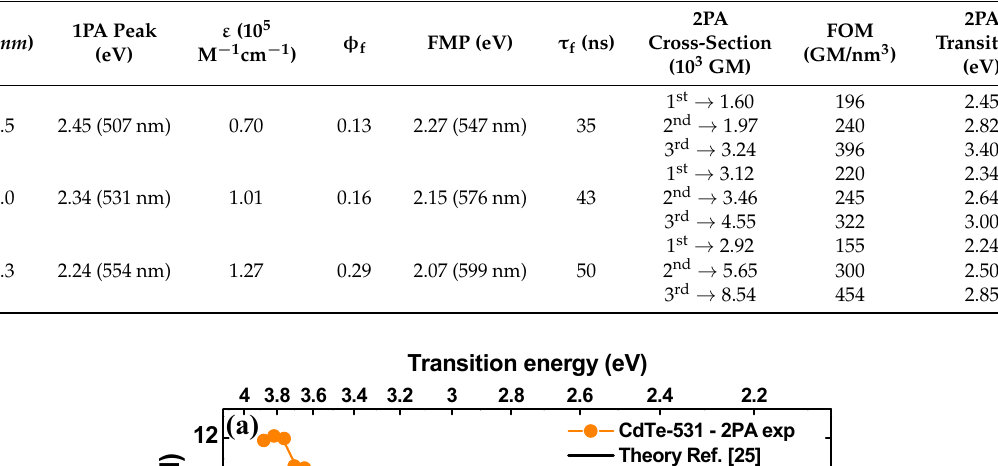
Table 1. Optical properties of CdTe-GSH QDs.